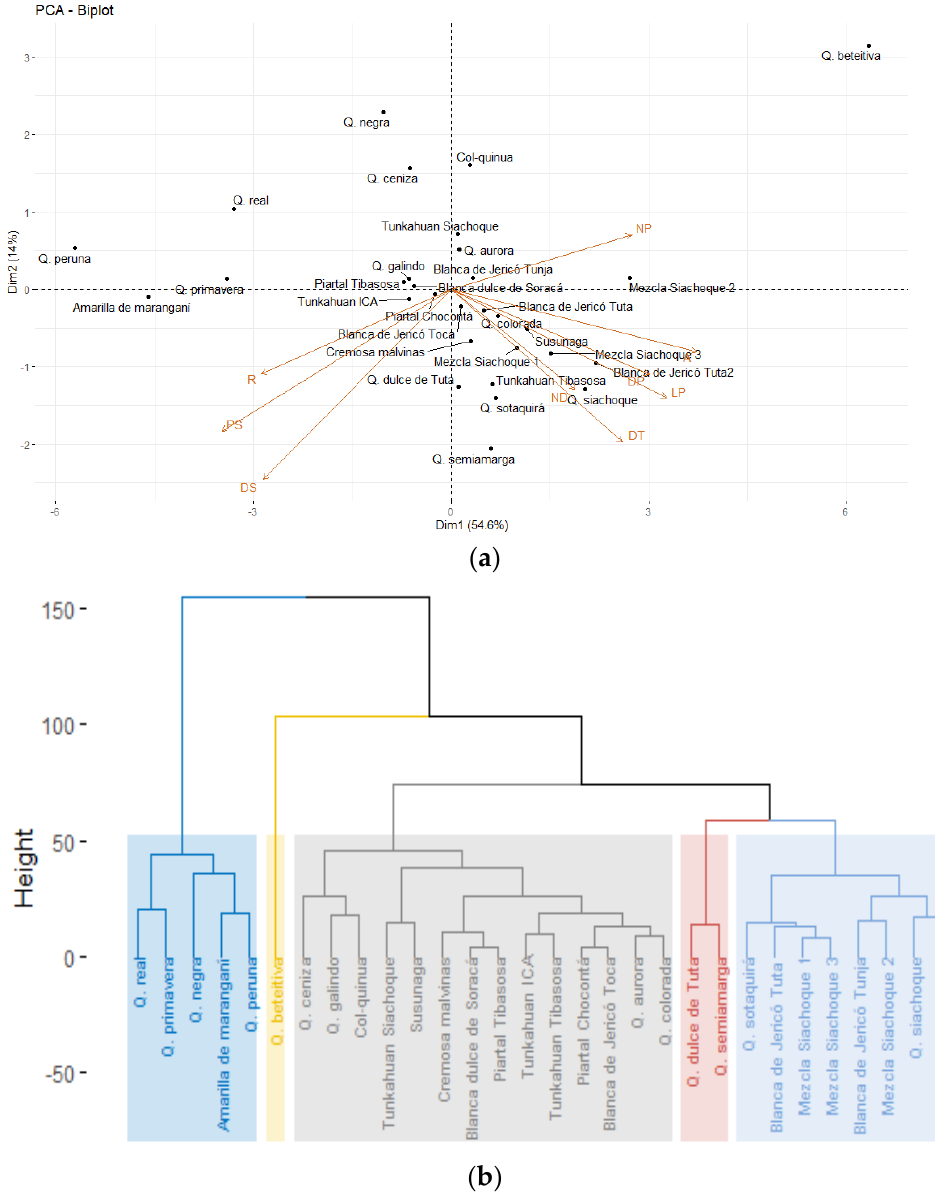
Figure 2. ( a ) Principal component analysis biplot. The variables that contributed to yield were weight and diameter of the seeds; ( b ) Hierarchical cluster analysis of quinoa accessions considering quantitative variables.